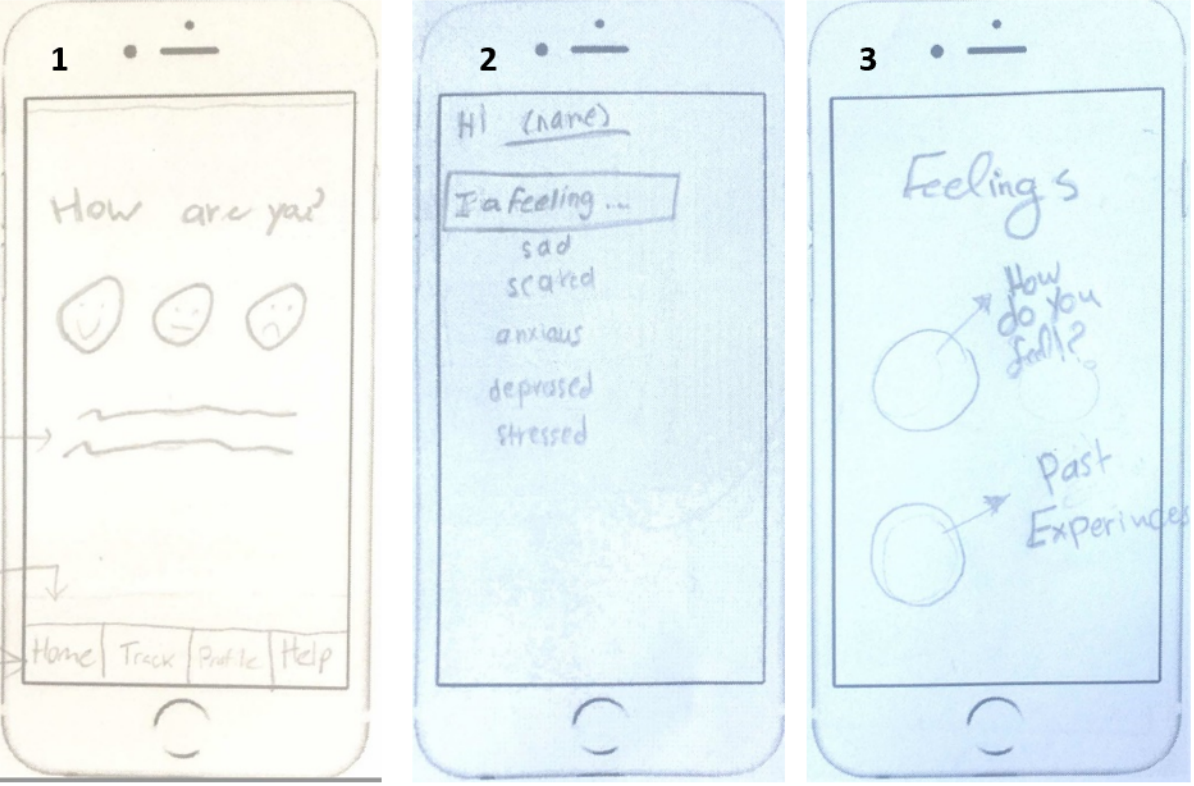
Figure 3. Three implementation ideas of a tracking feature were generated by participants: (1) simple tracker using a set of smiley faces, (2) using a set of emotion words, and (3) labeling one’s emotions in